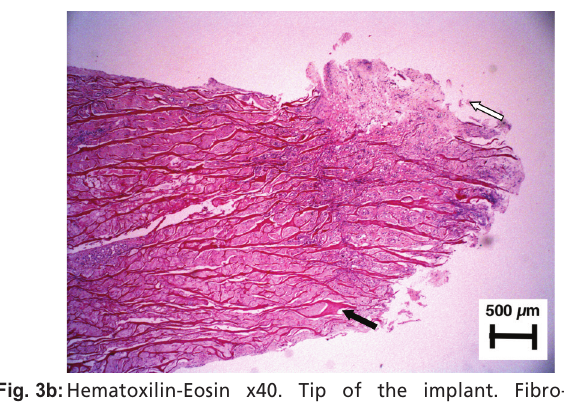
Hematoxilin-Eosin x40. Tip of the implant. Fibro- Fig. 3b: chondrocytes filling the spaces between the collagen mesh (black arrow). Outer growth of fibrochondroid tissue covering and making the implant longer (white arrow) can also be